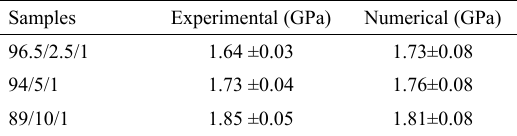
Table 5. Comparison of experimental and numerical Young´s modulus results Samples